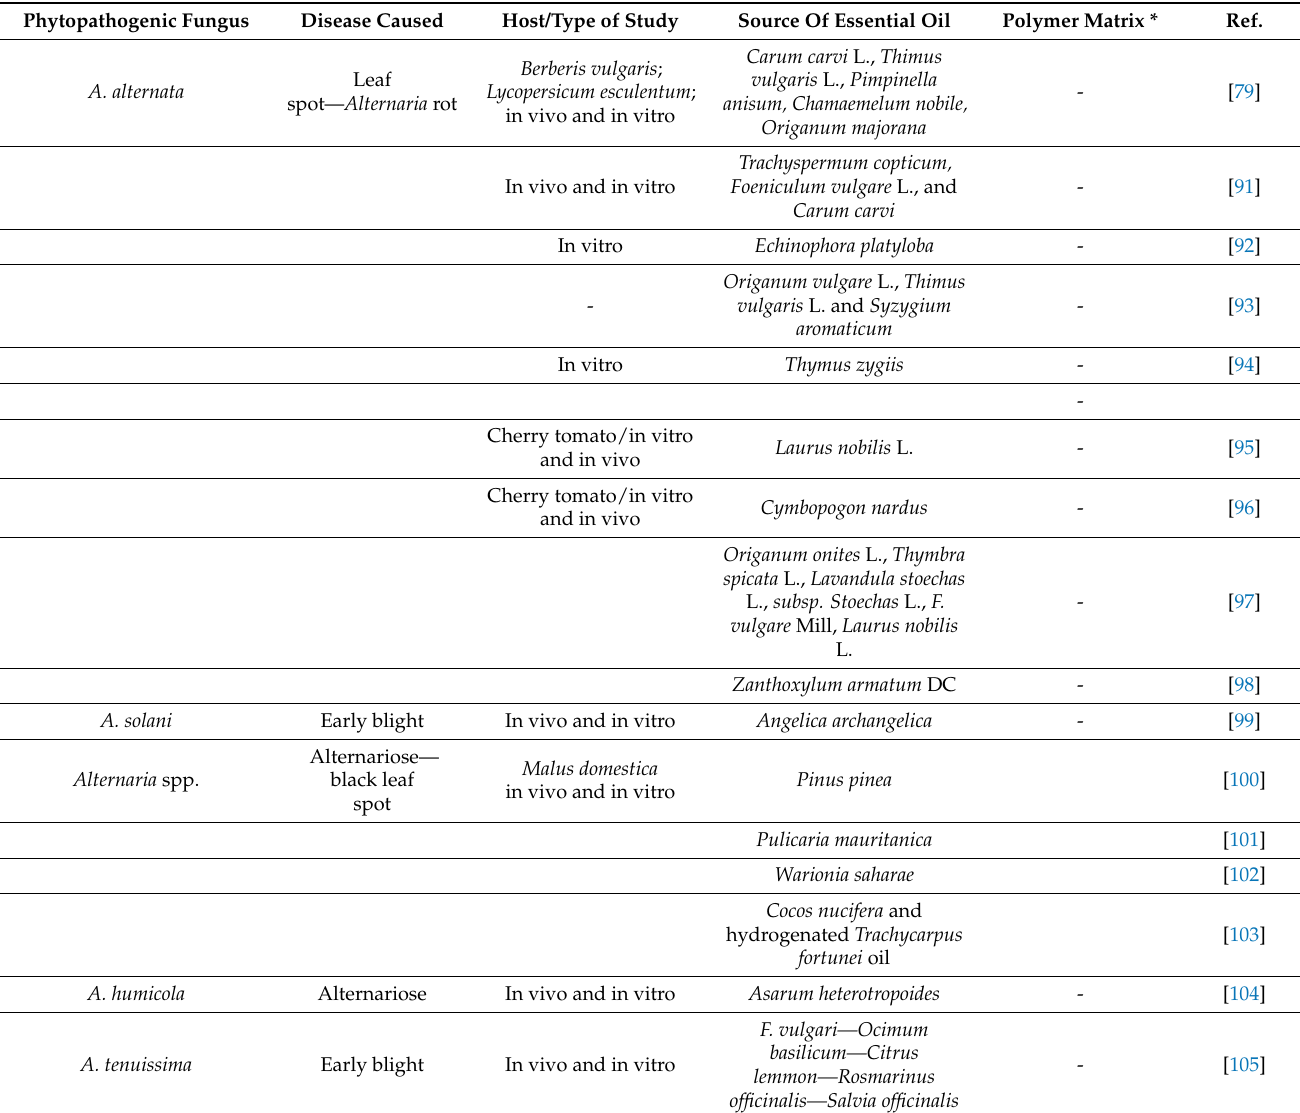
Table 2. Examples of free and encapsulated essential oils used to manage diseases caused by Alternaria